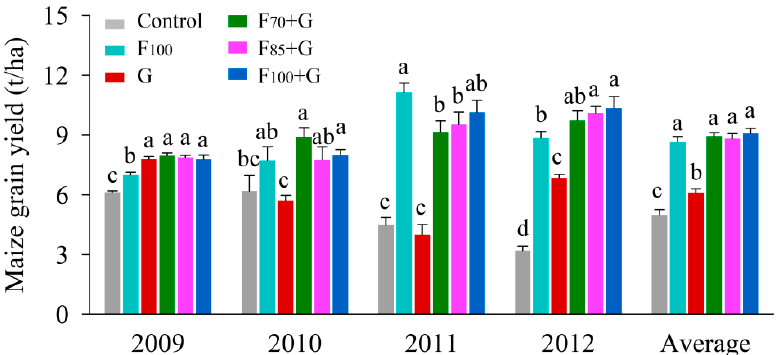
Figure 2. Maize grain yield and average yield from 2009 to 2012. Data are mean ± standard error (vertical bars, n = 4). Different letters above columns indicate statistical differences between treatments by least significant difference (LSD) test ( p < 0.05). Control, no fertilization; F 100 , recommended inorganic fertilization alone; G, green manure incorporation alone; F 70 + G, F 85 + G, and F 100 + G are 70%, 85%, and 100% of F 100 plus G, respectively.